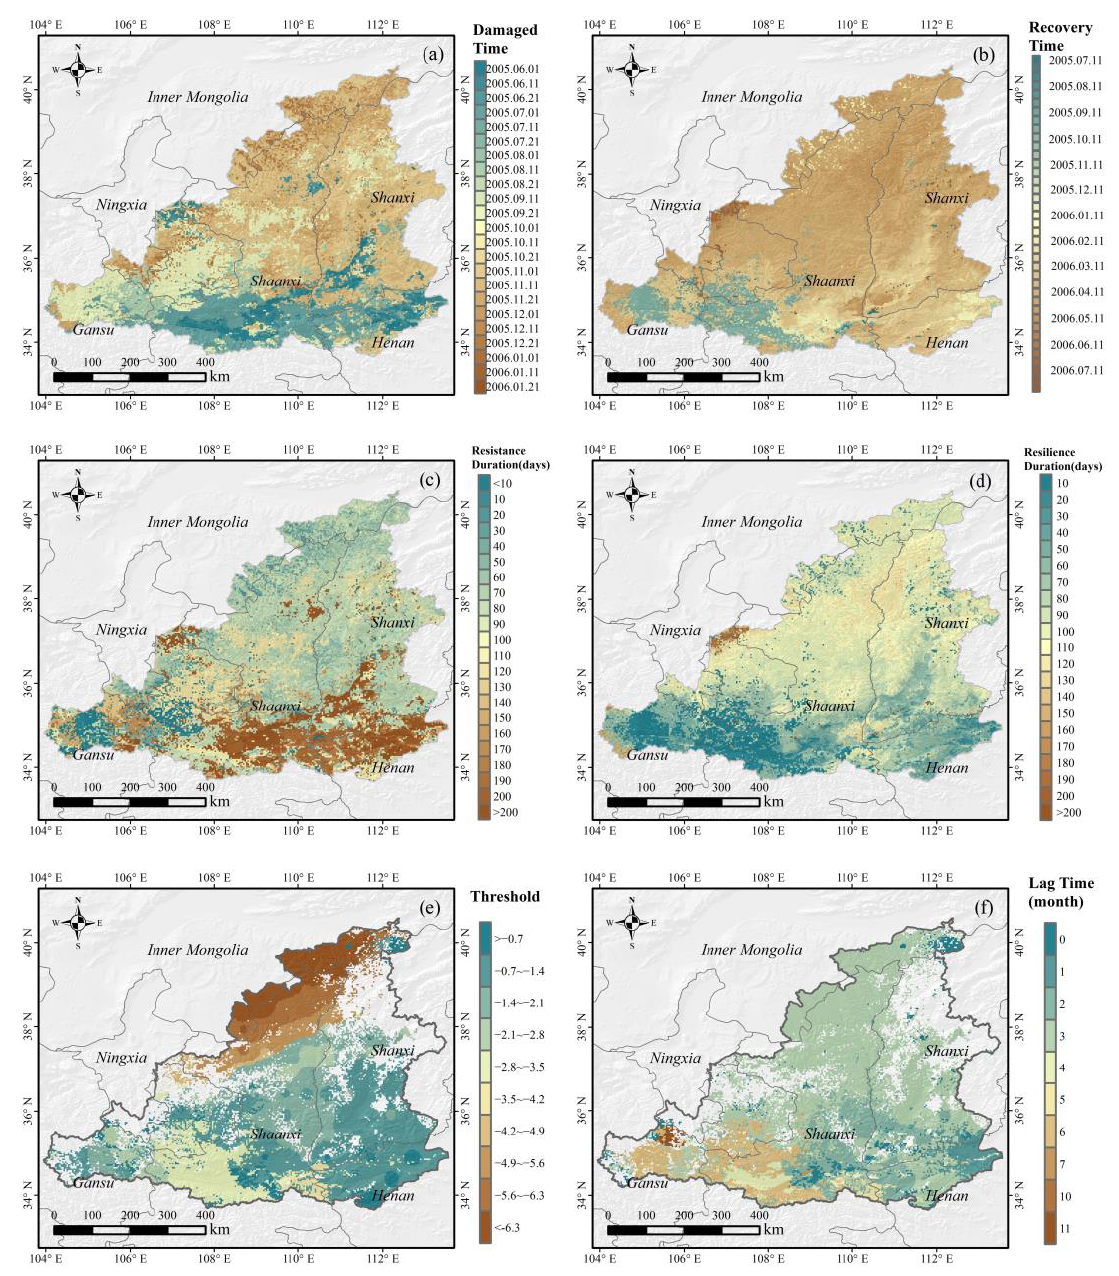
Figure 5. The spatial patterns of ( a ) the damaged time; ( b ) the recovery time; ( c ) the resistance duration; ( d ) the resilience duration; ( e ) the drought threshold; ( f ) the lag time. ( a – d ) were identified based on the standardized anomaly of NDVI. Areas with no data in ( e – f ) represent drought without serious impact on vegetation.